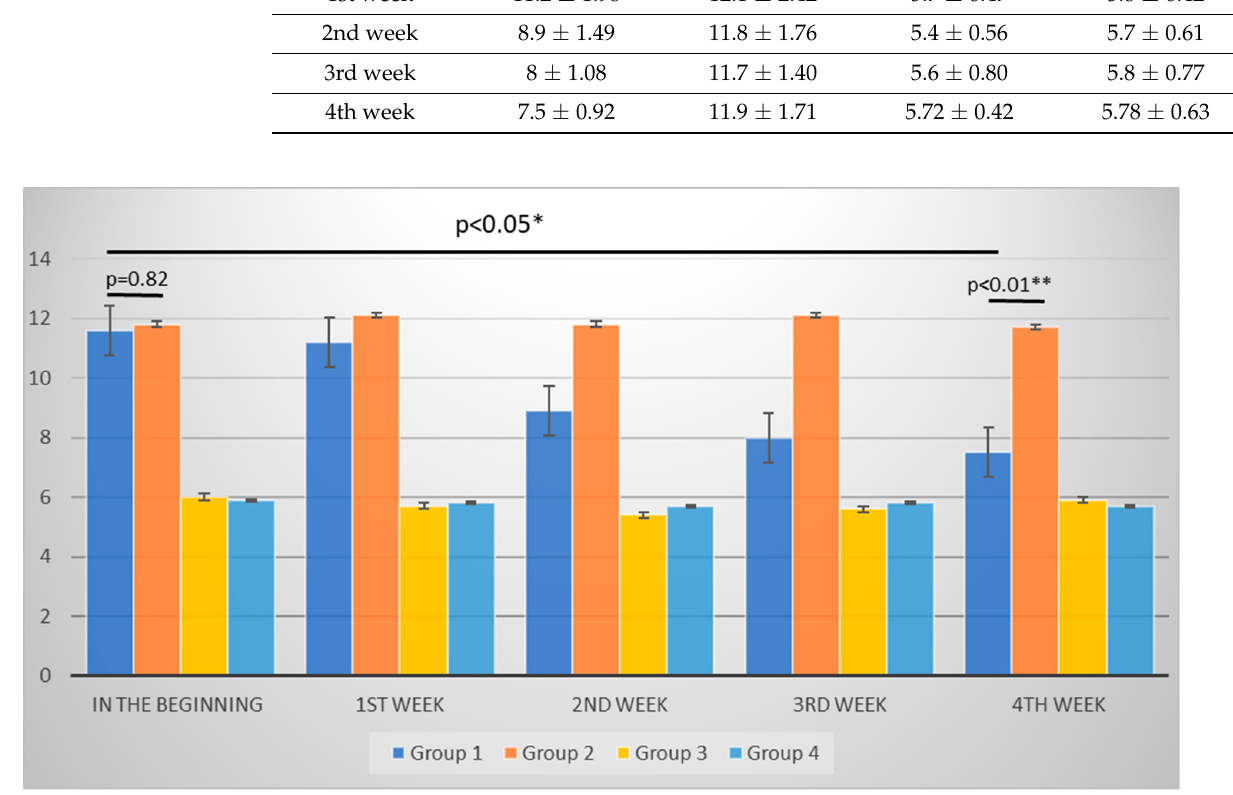
Figure 3. The average levels of blood glucose in the different groups, measured in mmol/L, given by week. Statistical signi fi cance: * p < 0.05, ** p < 0.01.